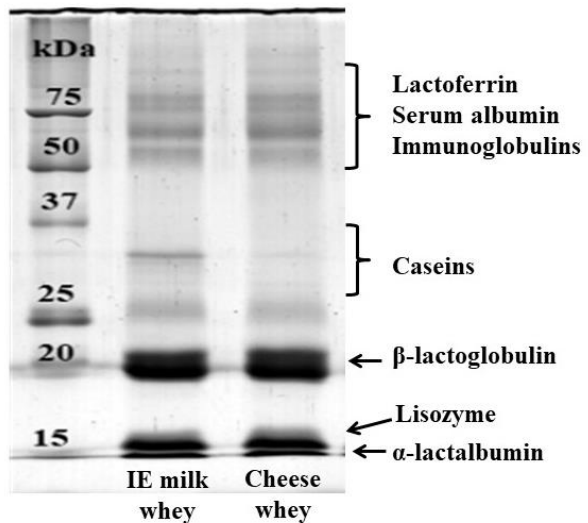
Figure 4. Sodium dodecyl sulphate (SDS)-PAGE patterns of isoelectric donkey milk whey (left slot) and donkey cheese whey after moulding (right slot).